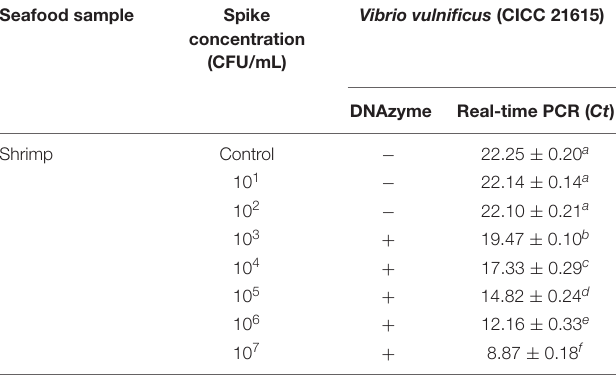
TABLE 4 | Detection of V. vulnificus in spiked seafood samples. Seafood